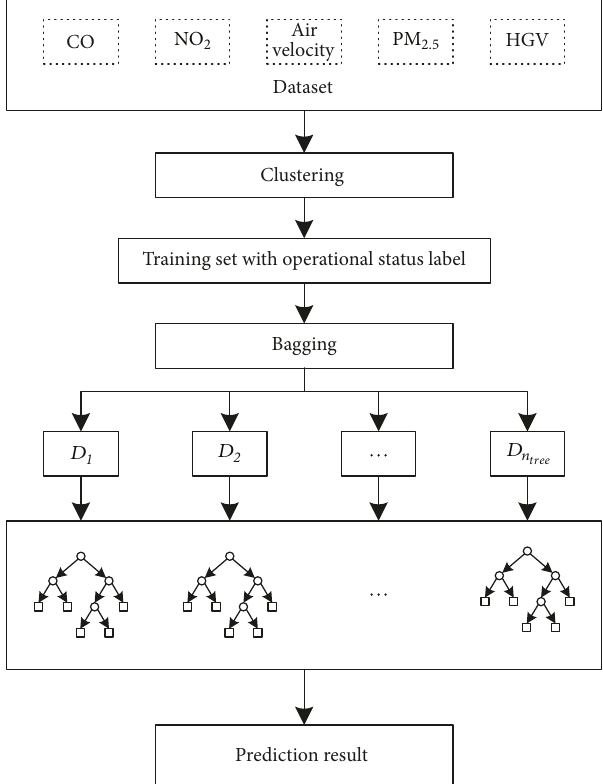
Figure 3: Diagram of Random Forests combining with clustering